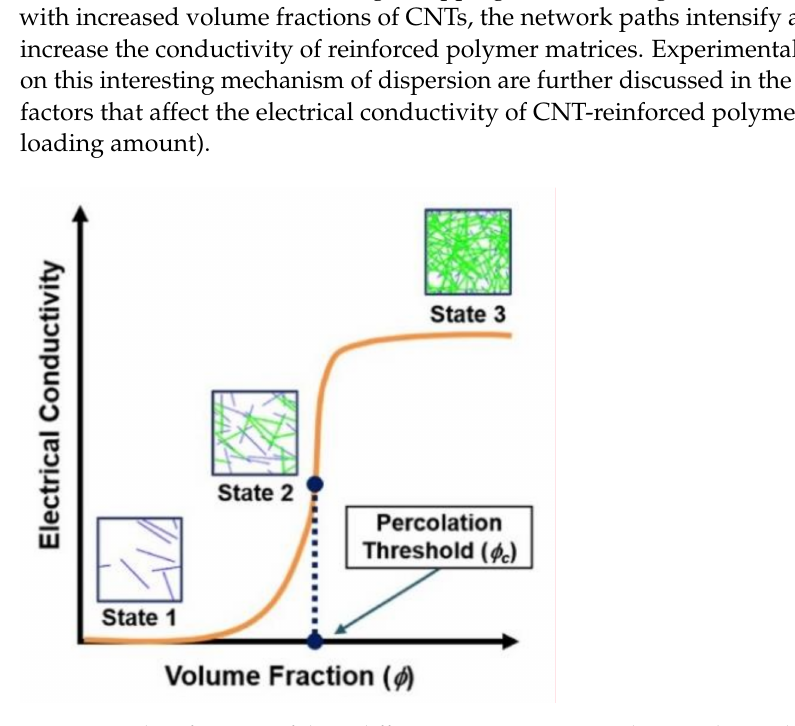
Figure 10. Classifications of three different states concerning the percolation theory-based electrical conductance transition for CNT-filled polymer nanocomposites. Reproduced from